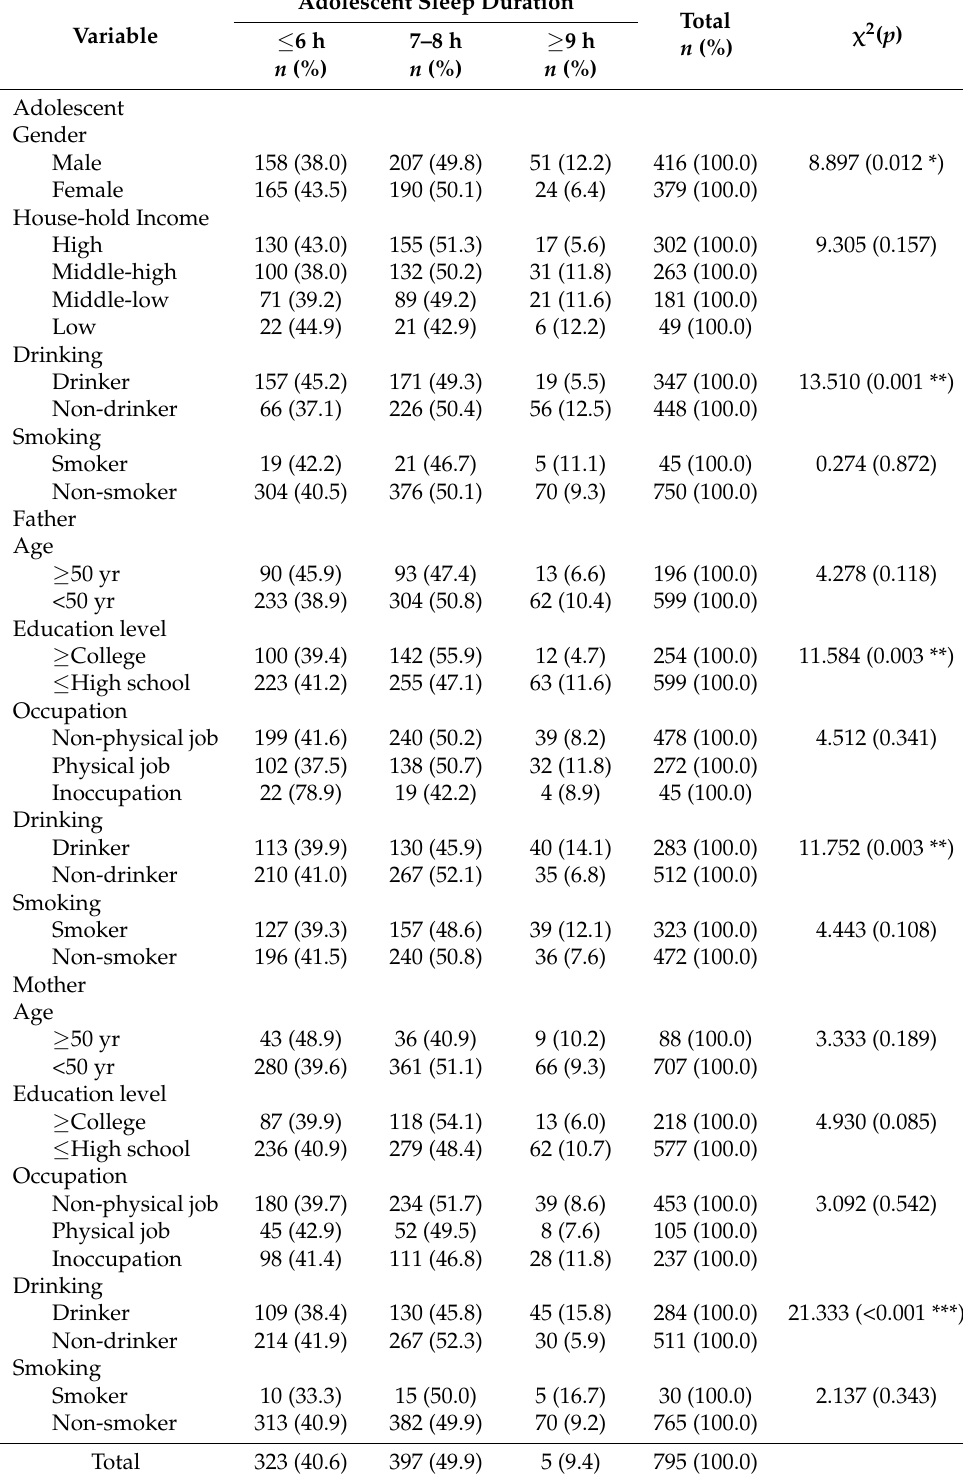
Table 3. Sleep duration according to the general characteristics of adolescents and